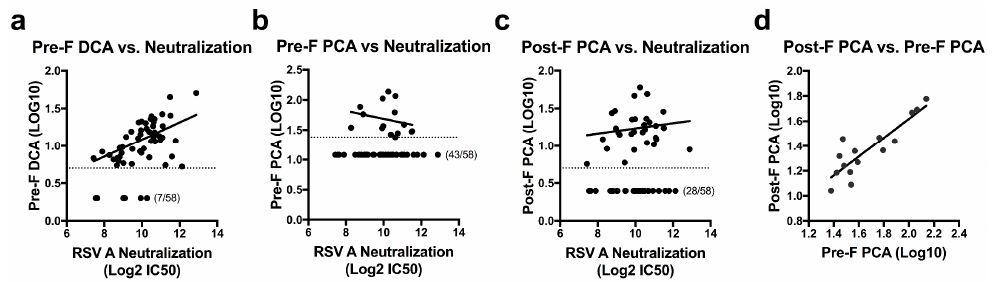
Figure 2. Quantitation of site-specific antibody concentrations and their correlation to neutralization in healthy human sera. ( a–c ) Pre-F DCA ( r = 0.487, p = 0.0003) ( a ), pre-F PCA ( r = − 0.335, p = 0.221) ( b ), and post-F PCA ( r = 0.126, p = 0.508) ( c ) levels were quantified and plotted against neutralization titers in 58 healthy human subjects. Dotted lines indicate the limit of quantitation for each assay (pre-F DCA: 4 µ g/mL, pre-F PCA: 24 µ g/mL, post-F PCA: 5 µ g/mL). Samples falling below the limit of quantitation were set at a value of half the limit of quantitation. Number of undetectable subjects are indicated. ( d ) Correlation of pre-F PCA and post-F PCA concentrations in the 15 subjects where both could be quantitated ( r = 0.793, p = 0.0007). All results were reported as the average of technical duplicates for each